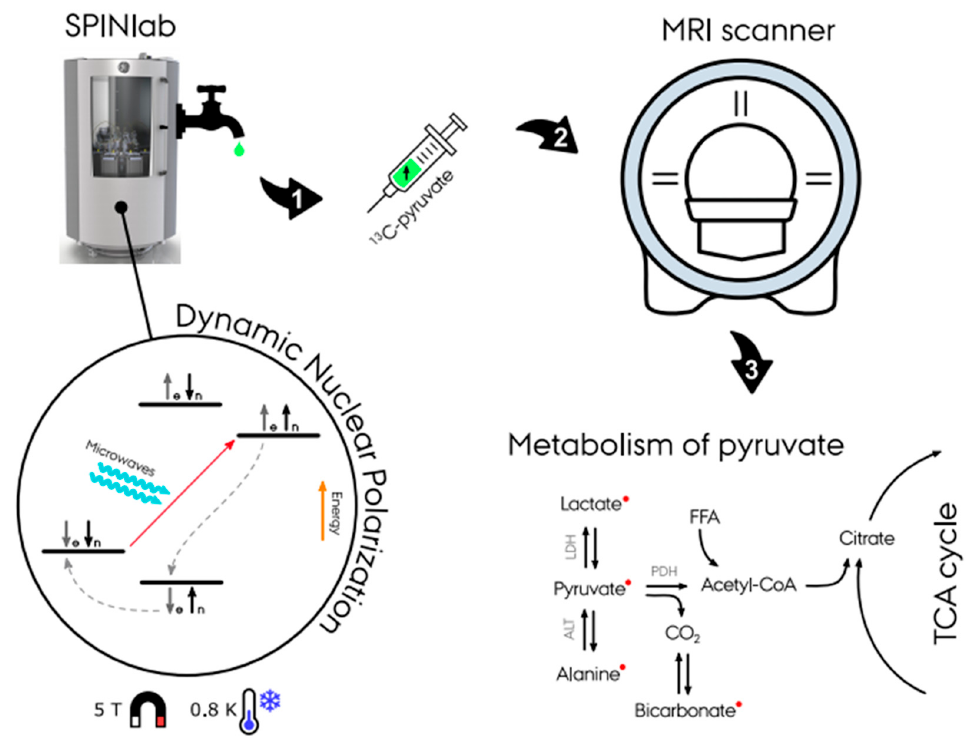
Figure 2. Illustration of the hyperpolarizing experiment in a SPINlab dissolution dynamic nuclear polarizer (d-DNP). First, the dissolution of 13 C-pyruvate is placed in a 0.8 K cold environment at 5 T within the DPN to achieve hyperpolarization. Secondly, the dissolution achieves massively increased magnetic properties and is ready for injection into the experiment subject. With the use of fast MR sequences, spectra and images of the pyruvate metabolism is achieved (Courtesy of Christian